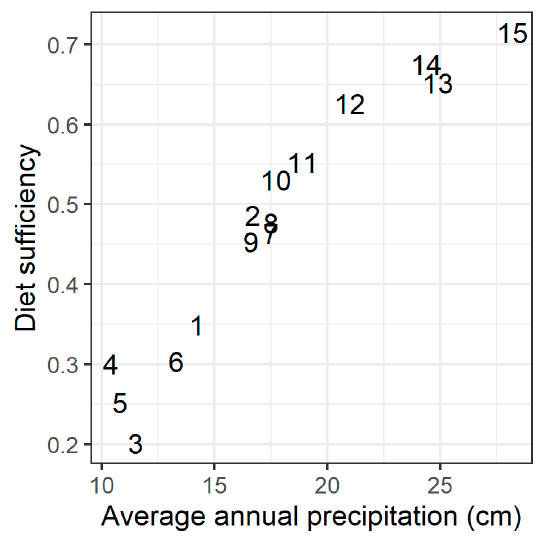
Figure A5. Average diet sufficiency at each site in the baseline scenario, under current climate conditions and empirical animal numbers. Sites are arranged here by average annual precipitation. Diet sufficiency values were averaged across twelve months and across pixels inside a 2400 ha simulated area at each site.